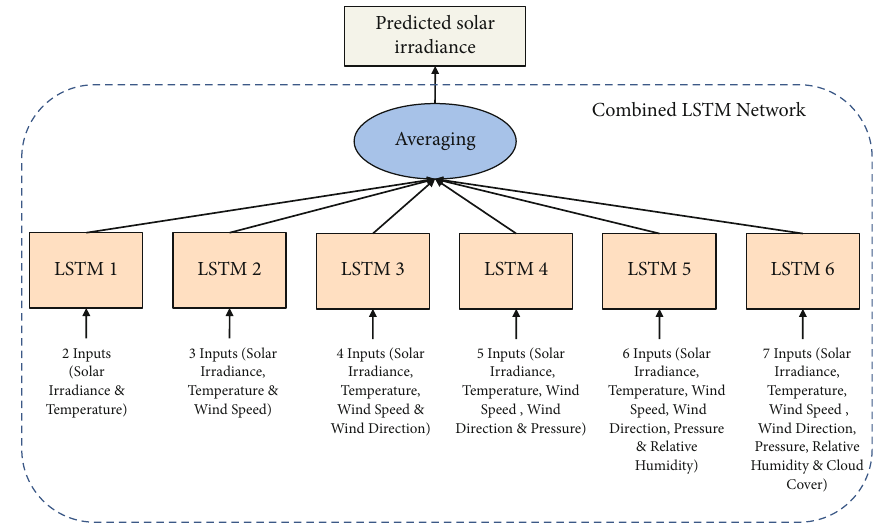
Figure 1: The framework of the proposed CLSTMN.